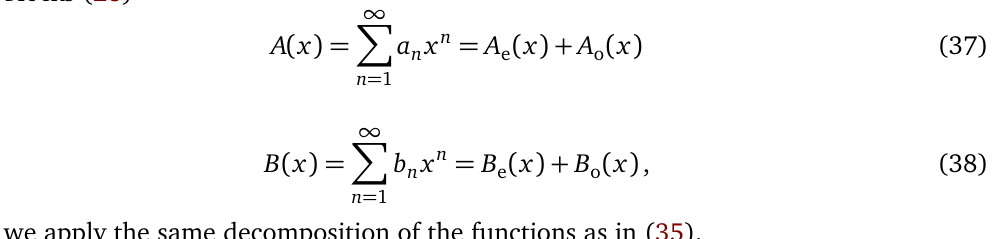
( 1 ) ( 1 ) ( 2 ) ( 2 ) ) , m m m 2 1 2 1 ( 1 ) ( 1 ) ( 2 ) ) from m m m 1 2 1 2 ( 2 ) ( 2 ) ( 1 ) ( 1 ) ) , we m m m 2 1 1 2